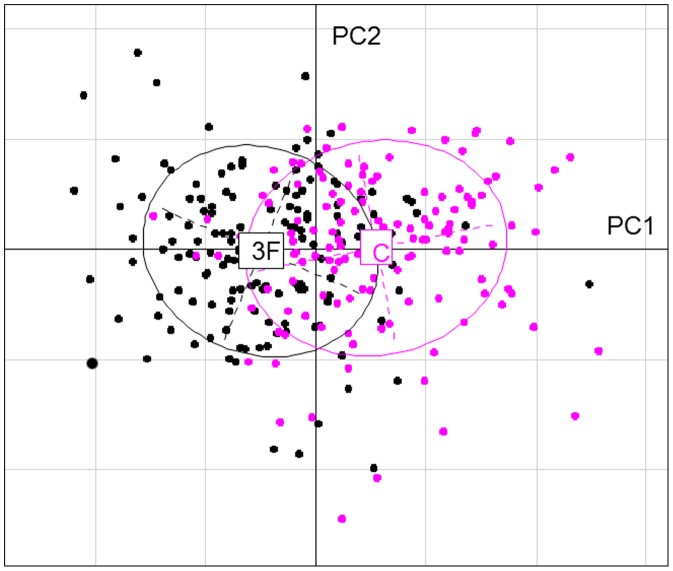
Contrast between populations.Projection of individuals from the two populations (C = Chizé, 3F = Trois Fontaines) on the first two principal component (displayed in the PC1-PC2 plane).